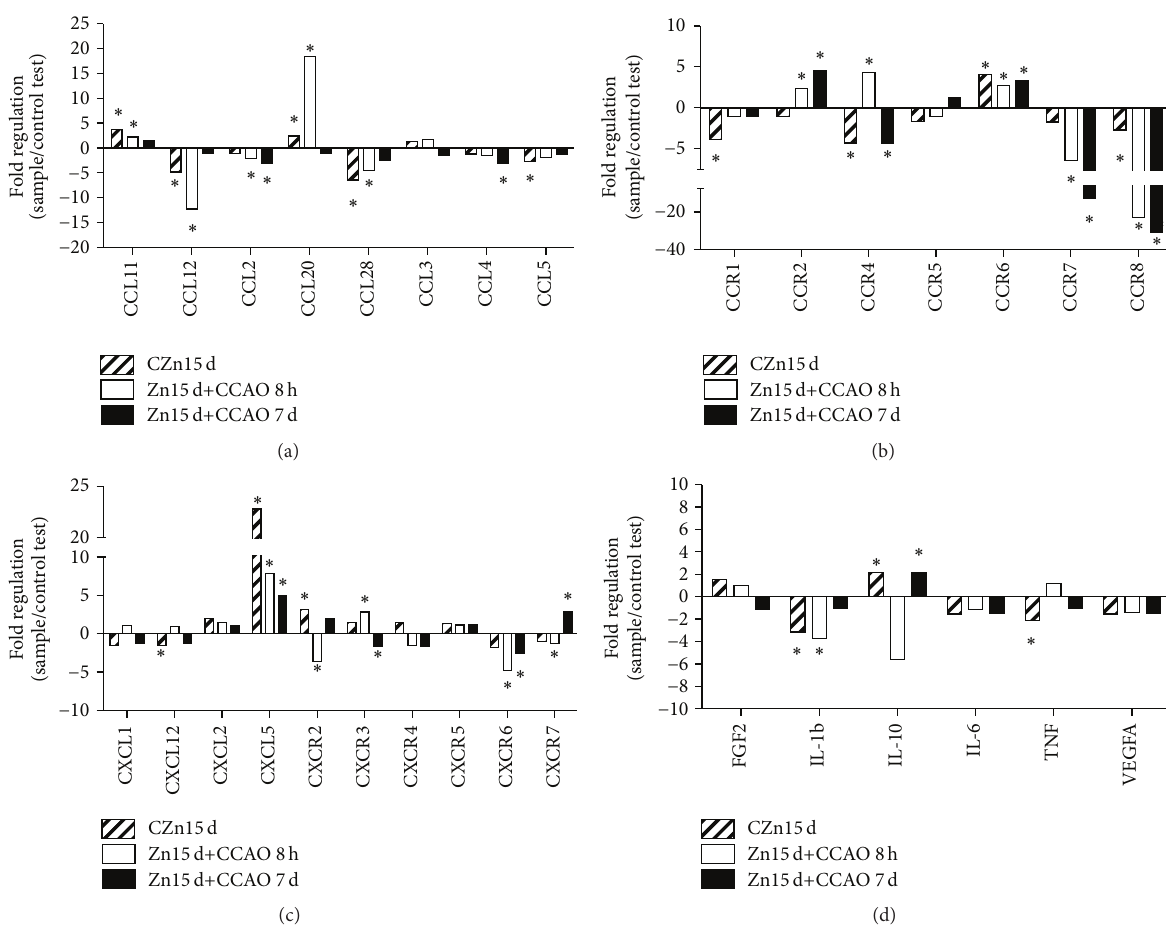
Figure 3: Effect of prophylactic chronic administration of zinc and CCAO on chemokine expression profile in the temporoparietal cortex- hippocampus using RT 2 Profiler PCR array. CZn15d, rats with chronic administration of zinc; Zn15d+CCAO 8 h, rats with chronic administration of zinc before CCAO and evaluations at 8 h after reperfusion; Zn15d+CCAO 7 d, rats with chronic administration of zinc before CCAO and evaluations at 7 days after reperfusion. Values show fold up- or downregulation as normalized with untreated control values. Each value represents the mean ± SEM of 3 independent experiments performed in triplicate. ∗ Significantly different from untreated rats (Student’s 𝑡 -test). The significance was established at 𝑃 < 0.05